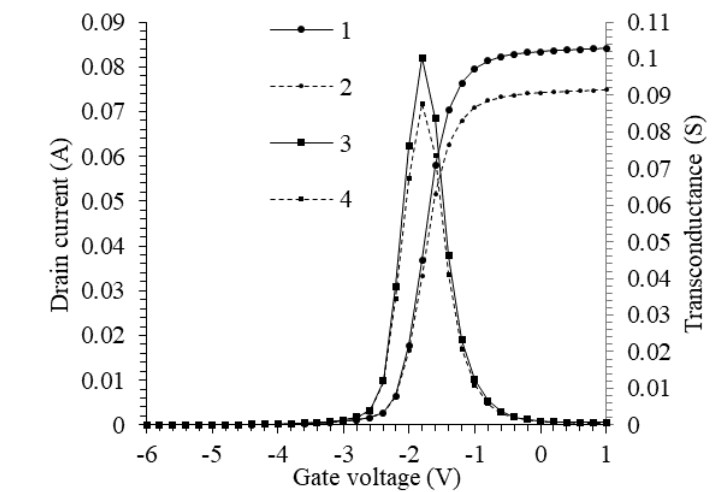
Fig. 4. Dependences of the drain current (1 and 2) and the transconductance (3 and 4) on the gate voltage at the drain voltage of 1 V: 1 and 3 – Sotoodeh mobility model, 2 and 4 – two-dimensional electron gas mobility